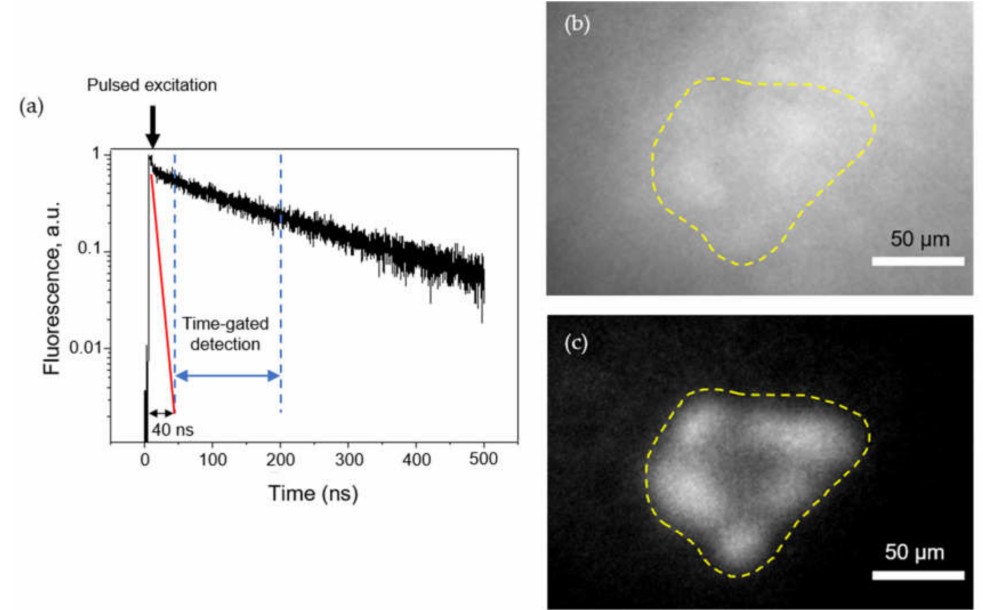
Figure 7. Time-gated imaging of QD-loaded co-culture HNSCC spheroids. ( a ) Autofluorescence (red) and fluorescence of QD-loaded spheroids (black) as a function of gate delay ∆ t (gate duration: 160 ns). The first dotted line corresponds to the 40 ns delay selected for the following experiments. Typical fluorescence images at ( b ) delay = 0 and ( c ) 40 ns, showing QD-loaded F5M5 spheroids deposited on a slice of tissue (scale bar = 50 µ m). The yellow dotted line displays the contour of F5M5